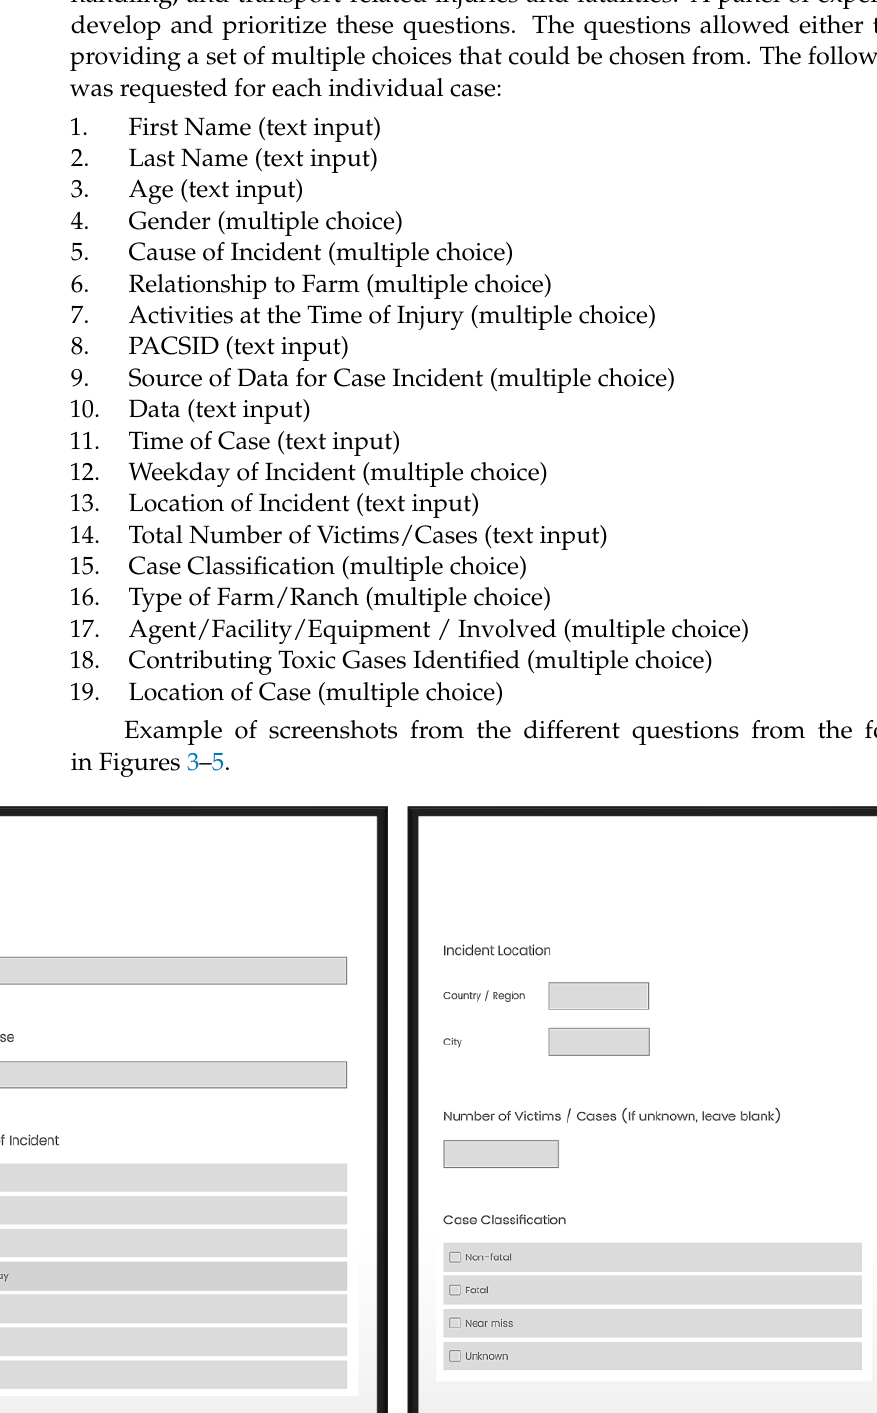
Figure 4. Qualtrics Survey Form: Farm Type and Agent involved.